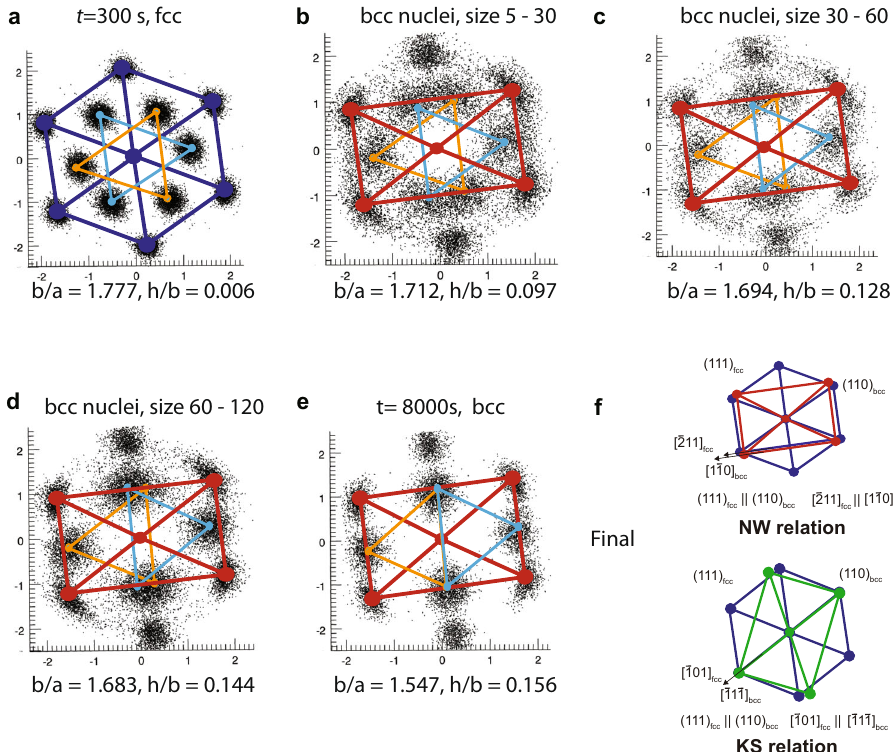
Fig. 4 The creation kinetics of NW/KS relationship. Scatter plots are 2D projections of Bond Orientation Order Diagrams (BOODs) of local nuclei. Spheres represent centres of clusters on BOODs, viewed as the averaged lattice structures. Two geometry metrics b / a and h / b are calculated from these averaged lattices, illustrating the transition from fcc ( b / a = 1.73, h / b = 0) to bcc ( b / a = 1.41, h / b = 0.167). a Averaged fcc lattice at 300 s after AOT substitution, calculated from a single big fcc grain. The fcc grain at this time is close to the perfect fcc lattice. b – d We select bcc nuclei with different sizes that are generated from the fcc grain in panel a and calculate their averaged lattices. As the size of bcc nuclei increases, the lattice structures change gradually from fcc to bcc. Signi fi cant changes will fi rst be seen on h / b , caused by inter-layer adjusting. e At 8000 s after the AOT substitution, the fcc grain we investigate has mostly evolved into bcc solid while keeping the speci fi c orientation relation. The bcc grain at this time will undergo further intra-layer adjustments to modify b / a . f The transition kinetics results in two speci fi c orientation relations between the fcc mother lattice and bcc product lattice: Nishiyama – Wasserman (NW) and Kurdjumov – Sachs (KS)